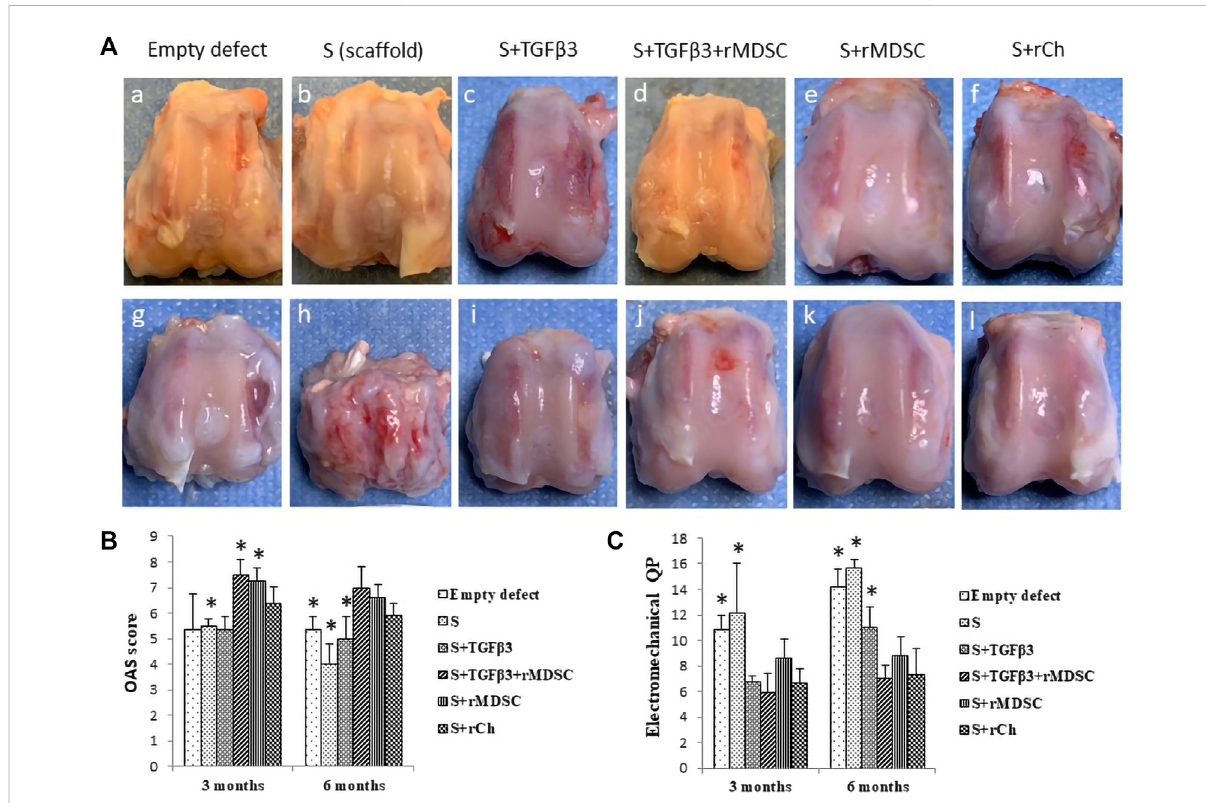
FIGURE 4 Healing of cartilage defects with different scaffolds after 3 (A – F) and 6 (g, h, i, j, k, and l) months (A) . Macroscopic evaluation of cartilage defect healingaccordingtotheOswestryArthroscopyScore(OAS) (B) .Evaluationofcartilageelectromechanicalquantitativeparameters(QPs)byusingthe Arthro-BST device (C) .Results are presented asmean ±standarddeviation.*represents p -value < 0.05 compared to Scwithother scaffolds — S,Stm, and Sm at 3 months. In addition, the p -value < 0.05 represents the difference compared to Sc with E, S, and St at 6 months (B) . p -value < 0.05showedas*indicatessigni fi cantdifferencesbetweenScandEorSscaffoldsat3 months,alsocomparingScwithE,S,andStscaffolds at 6 months (C) . S, scaffold; TGF β 3, transforming growth factor-beta 3; rMDSCs, rabbit muscle-derived stem cells; rCh, rabbit